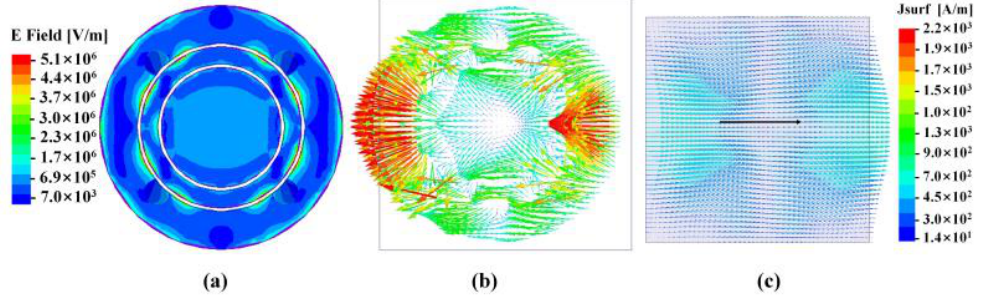
Figure 5. The simulated ( a ) electric field distribution and ( b ) surface current density of the first graphene layer and ( c ) surface current density of the backed Au ground at f 1 = 3.8